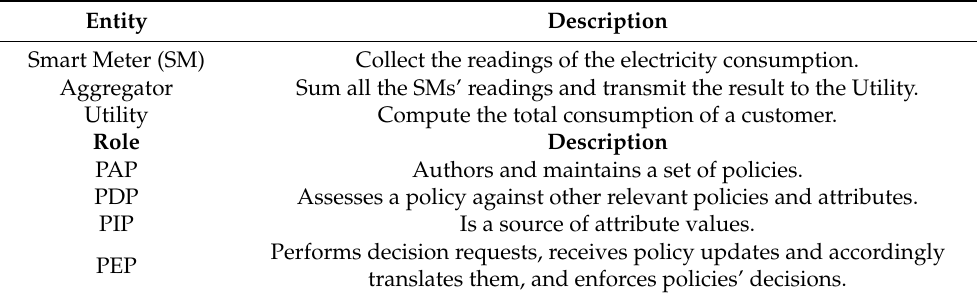
Table 2. Main entities and roles participating in SAMGRID.